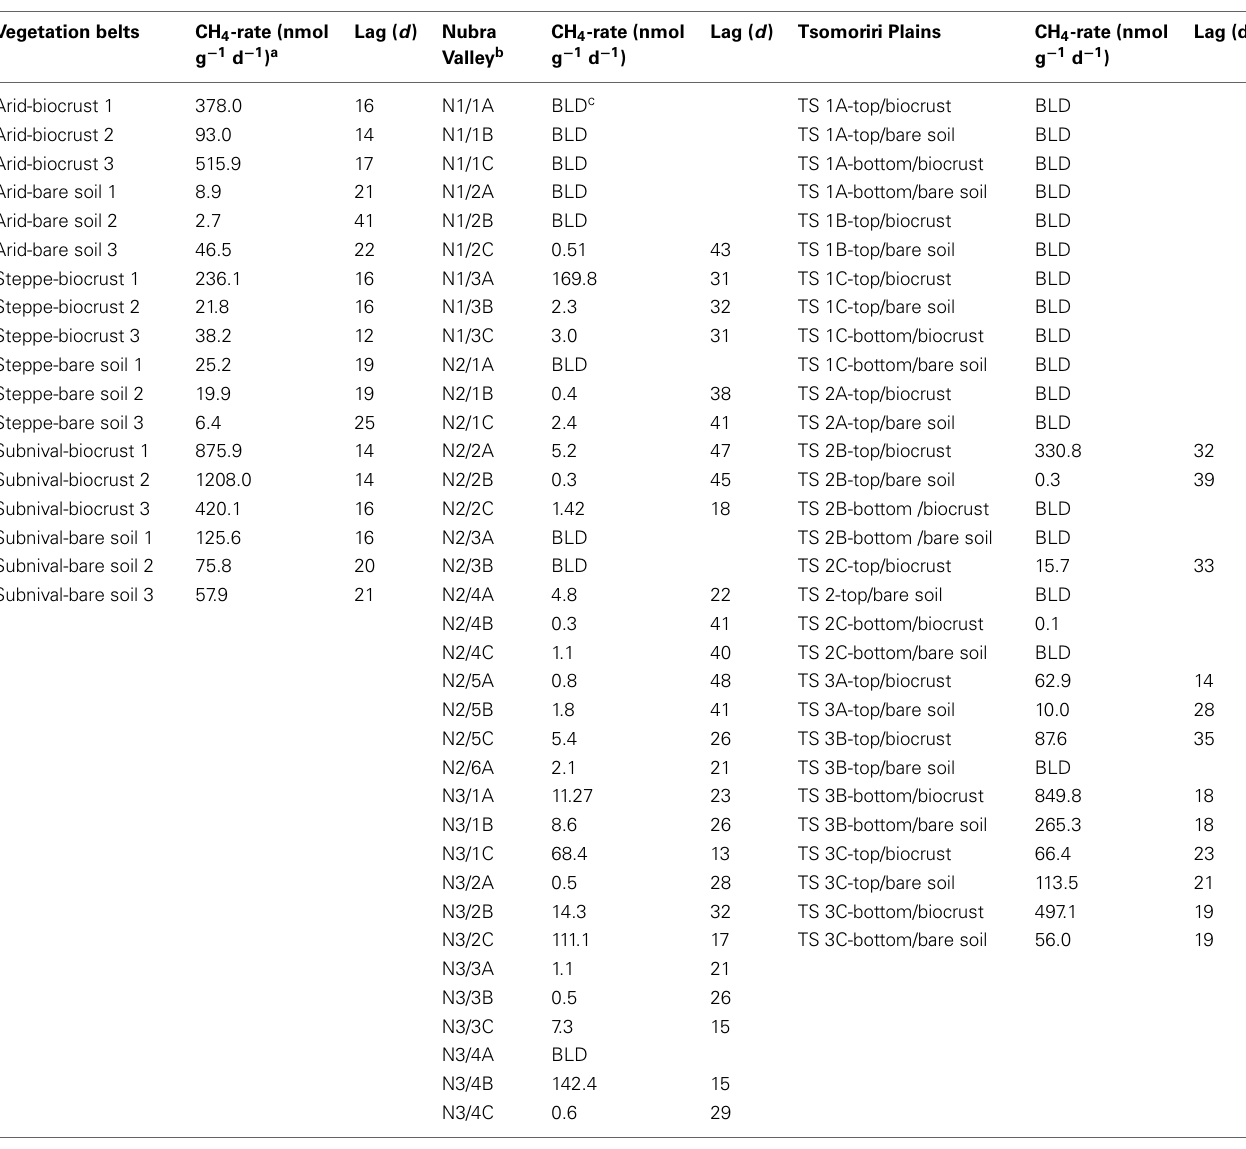
Table A1 | Methane production rates and lag times of all